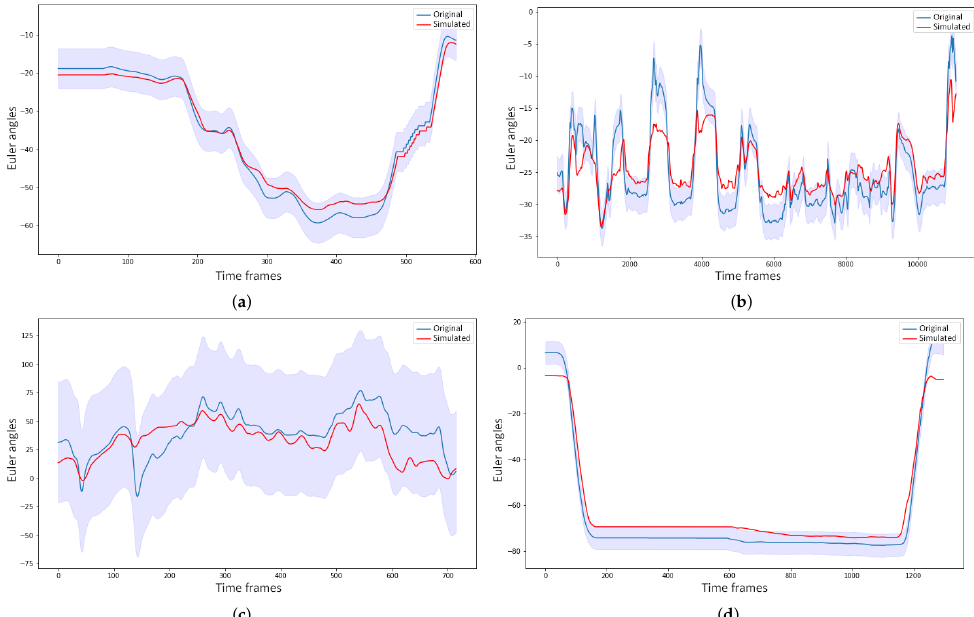
Figure 8. Examples of simulated gestures, their original gesture, and confidence bounds of 95% ( a ) Simulation of the gesture G 1,3 on the joint angle LA X ; ( b ) The simulated joint angle sequence of S Z for G 2,3 ; ( c ) Simulation of LFA Y for the gesture G 3,1 ; ( d ) Forecasting of RA X for G 4,9 , which consists of raising the forearms above the shoulder